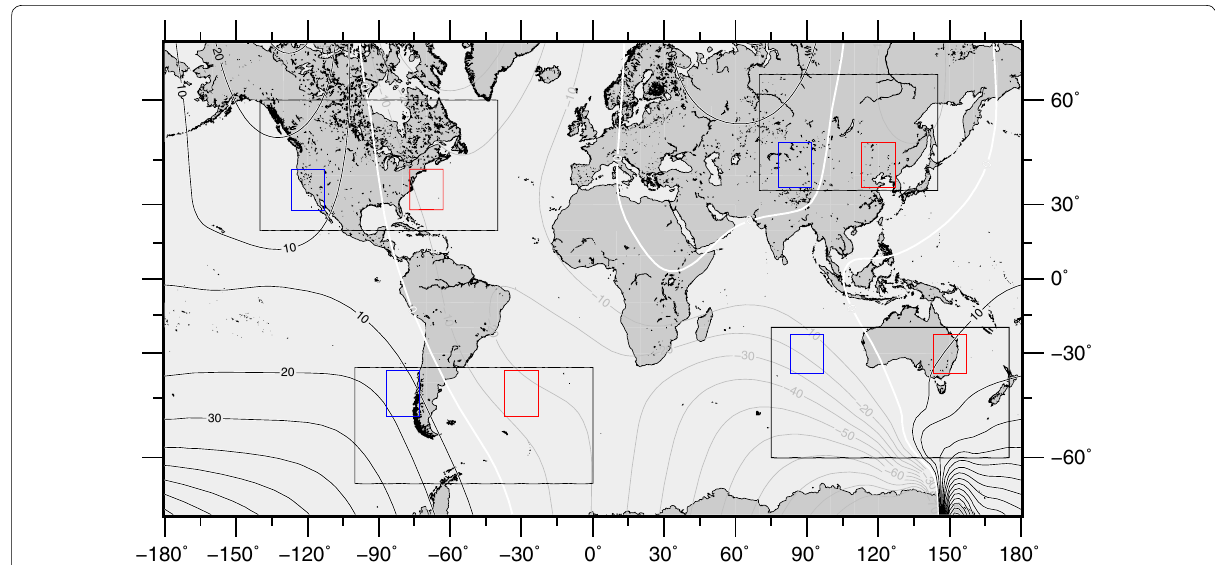
Fig. 1 Regions in the northern and southern hemisphere approximately centered at zero magnetic declination. The zero magnetic declination is along the white